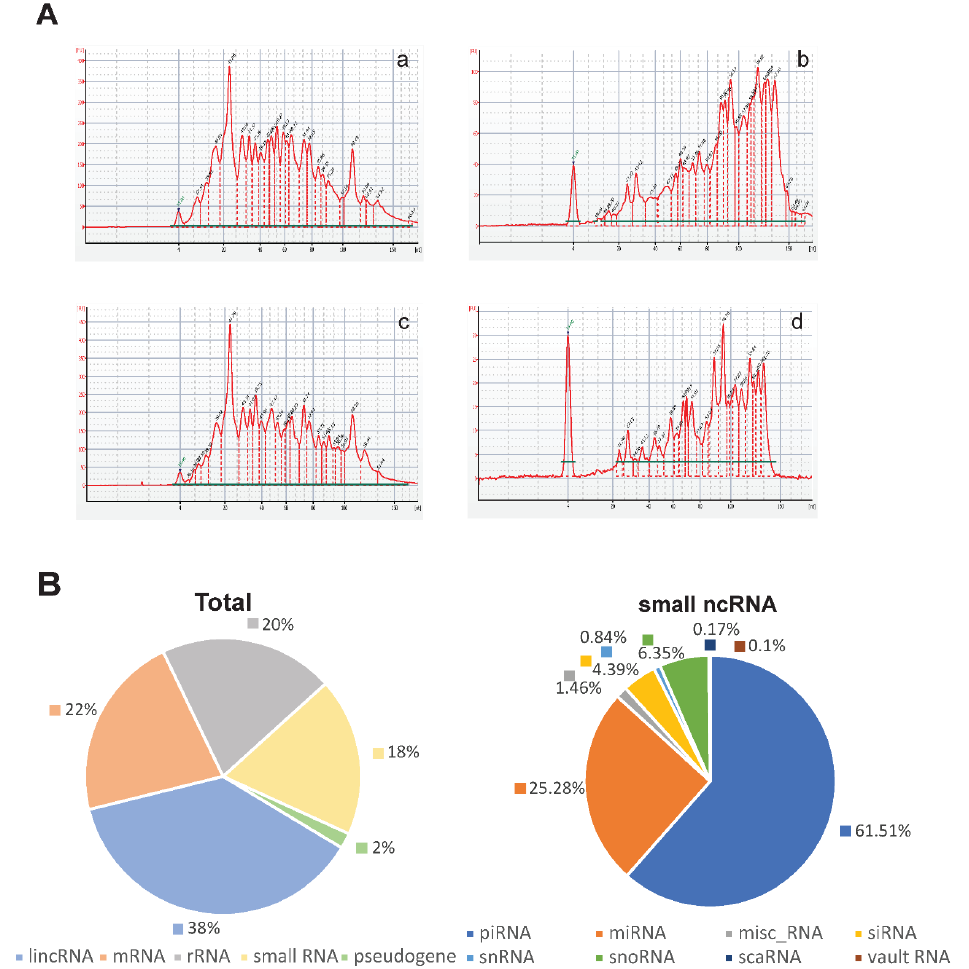
Figure 3. Characteristics of small RNAs present in EVs isolated from UA. Agilent Bioanalyzer profiles of the small RNA. Size distribution and perczentage of the miRNA. ( A ) Examples of small RNA analysis for 4 EV preparations (( a , b )—from EOC and ( c , d )—from normal UA samples), illustrating relatively high and low contents of molecules corresponding to the sizes of miRNAs. ( B ) RNA content of the EVs according to small RNA-seq data. The mean share percentage for different RNA types is presented.